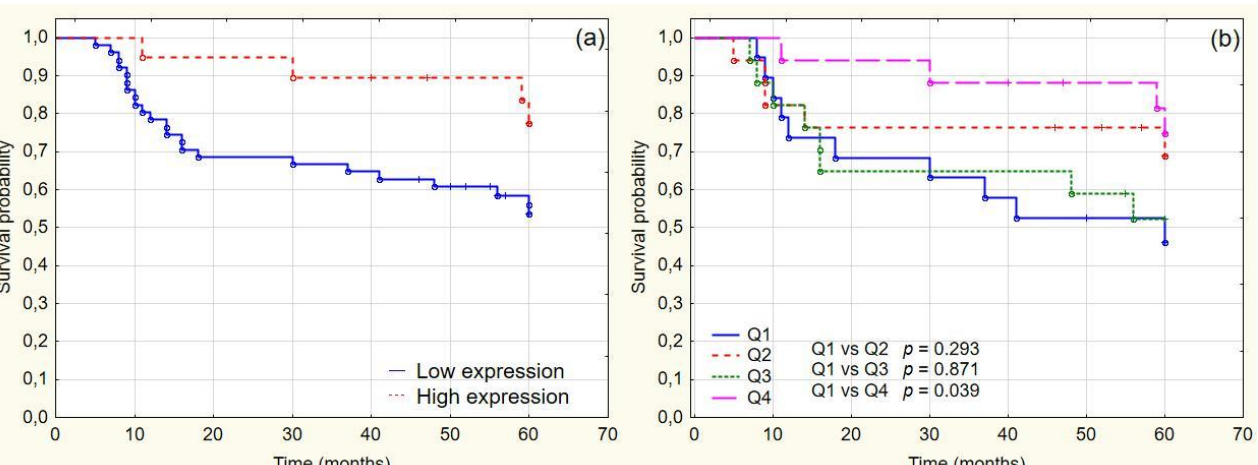
Univariate Cox regression analysis showed that the type of procedure, stage, grade, invasiveness, tumor size, lymph node invasion, presence of distant metastases, and pro- gression were significant prognostic factors. In multivariate analysis, only the occurrence of progression remained statistically significant (<0.05) (Table 3). CDK9 status was not